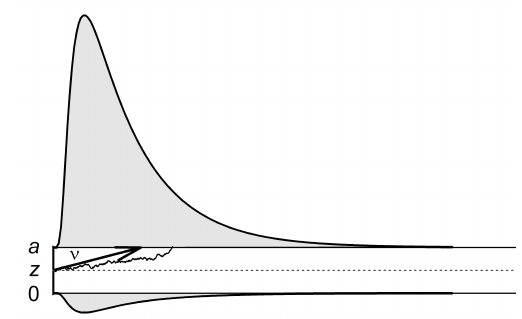
Figure 1. The diffusion model. The accumulation process starts at starting point z , moves with average slope v , and terminates when one of the two thresholds (0 or a ) has been